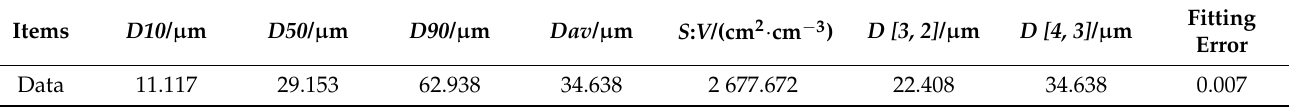
Table 2. Particle size test data